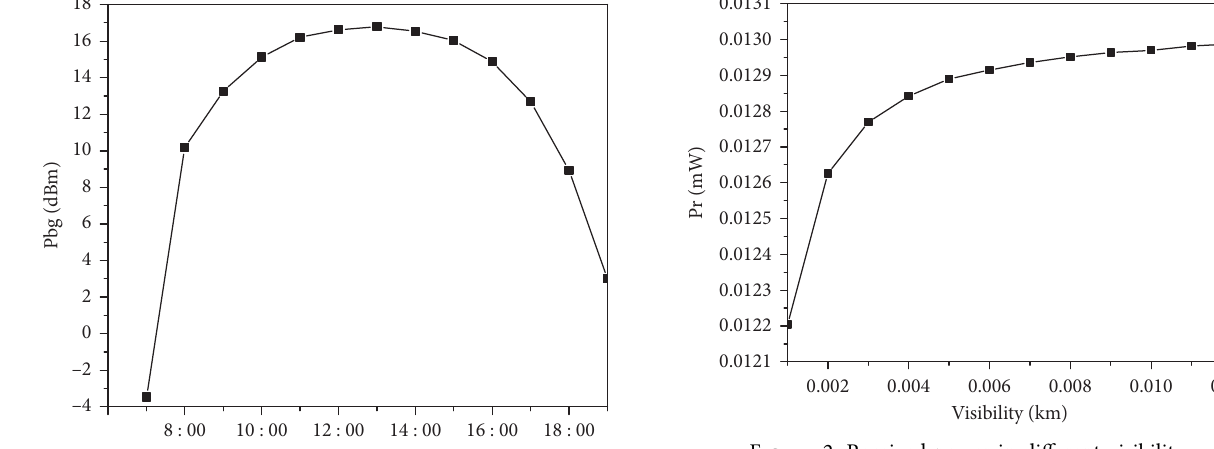
Figure 2: Received power in different visibility.